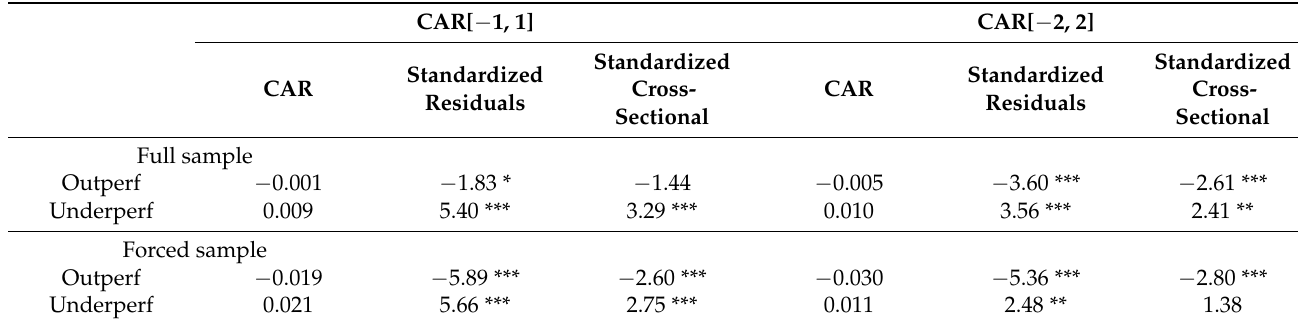
Table 9. Robustness of abnormal returns.